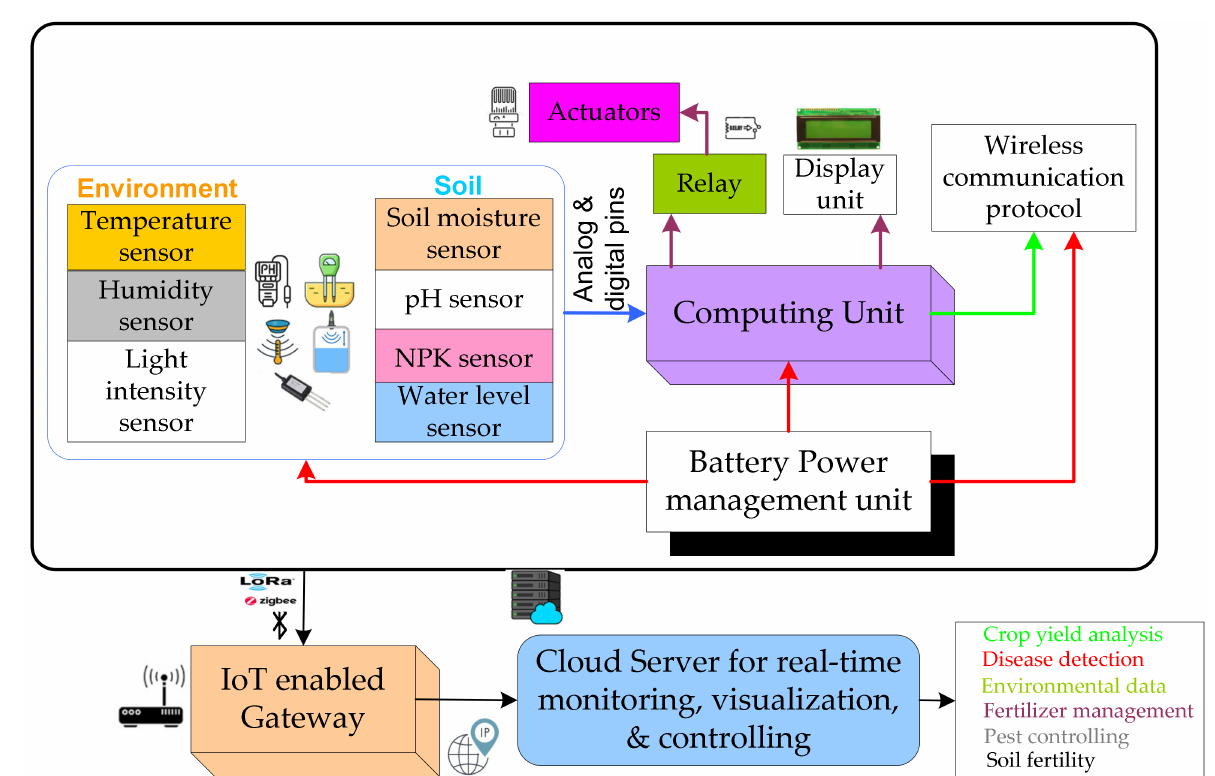
Figure 2. IoT for